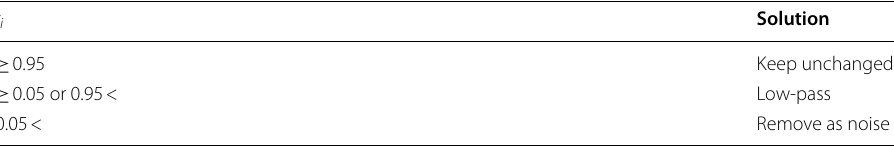
Table 1 The solution according to similarity r i r i Solution 0.95 Keep unchanged ≥ 0.05 or 0.95 < Low‑pass ≥ 0.05 < Remove as